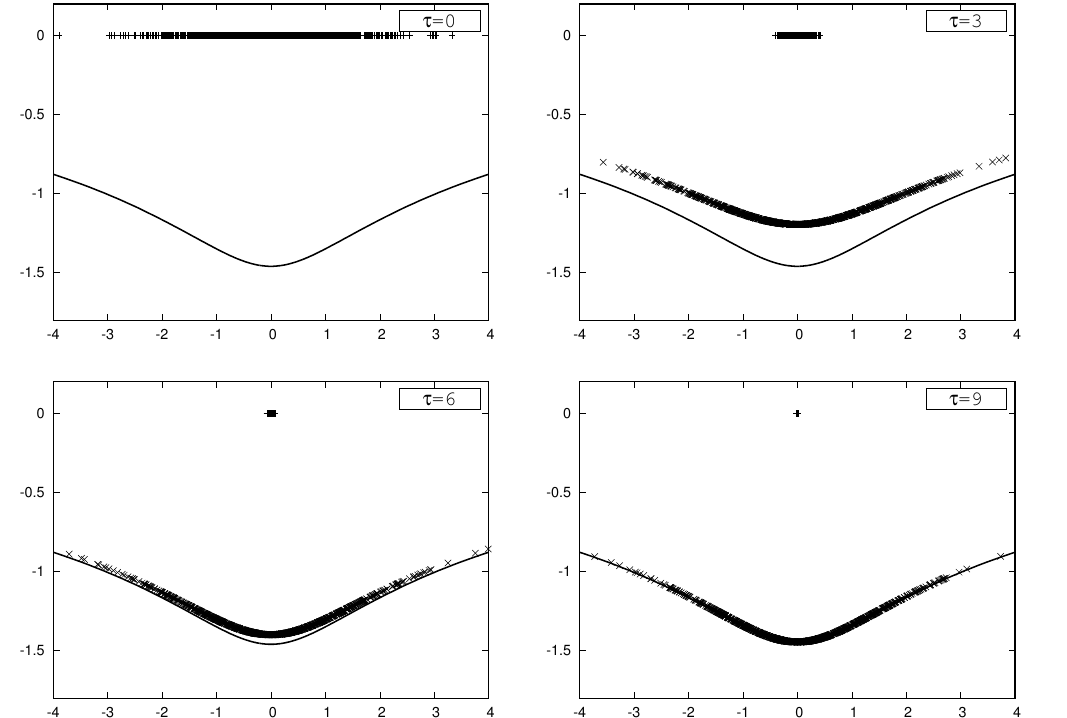
Figure 3 . The distribution of z (represented by \+") and (cid:13)owed con(cid:12)gurations (represented by \ (cid:2) ") obtained by applying the RLM to the phase quenched model (4.4) are plotted for (cid:28) = 0 ; 3 ; 6 ; 9 from Top-Left to Bottom-Right. The solid line represents the Lefschetz thimble. At (cid:28) = 0, the distribution of z and (cid:13)owed con(cid:12)gurations